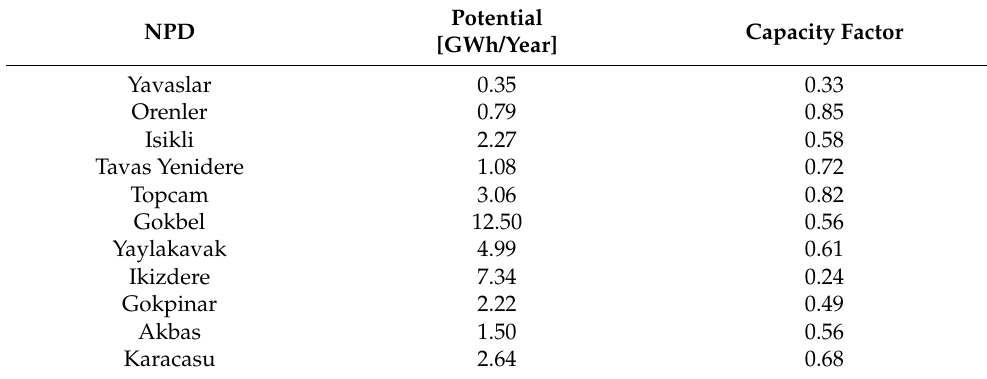
Table 3. Annual power potential and the capacity factors for the NPDs.